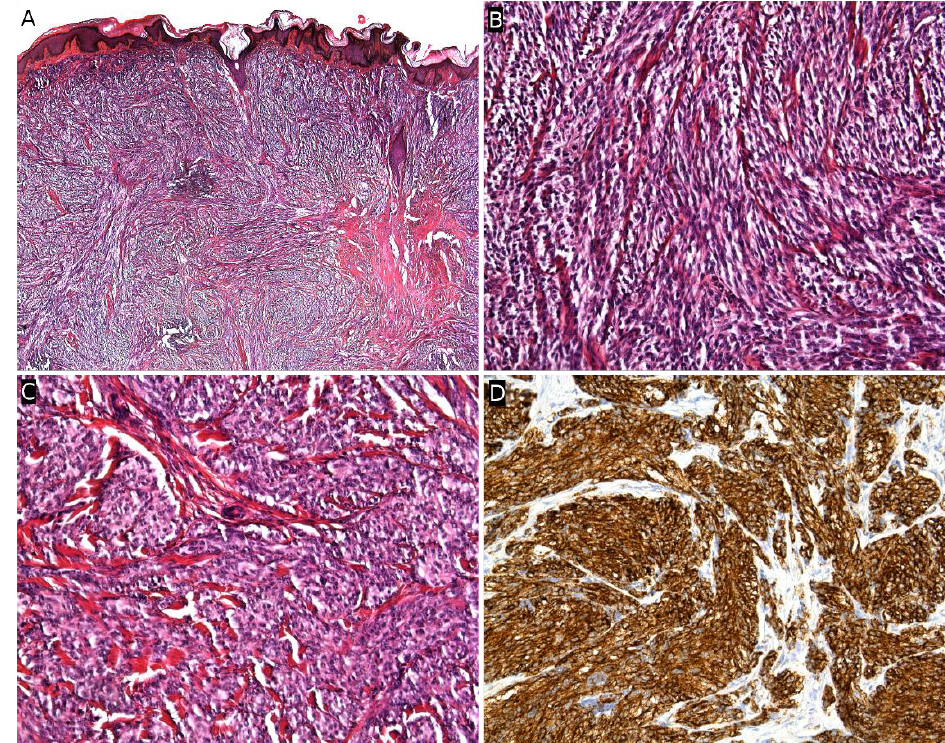
Figure 16. Clear cell sarcoma of soft tissue: ( A ) Densel cellular dermal and subcutaneous proliferation (×25); ( B ) uniform clear cells in fascicles (×100); ( C ) clear cells with no or slight nuclear atypia (×100); ( D ) diffuse HMB45 positivity (×100).